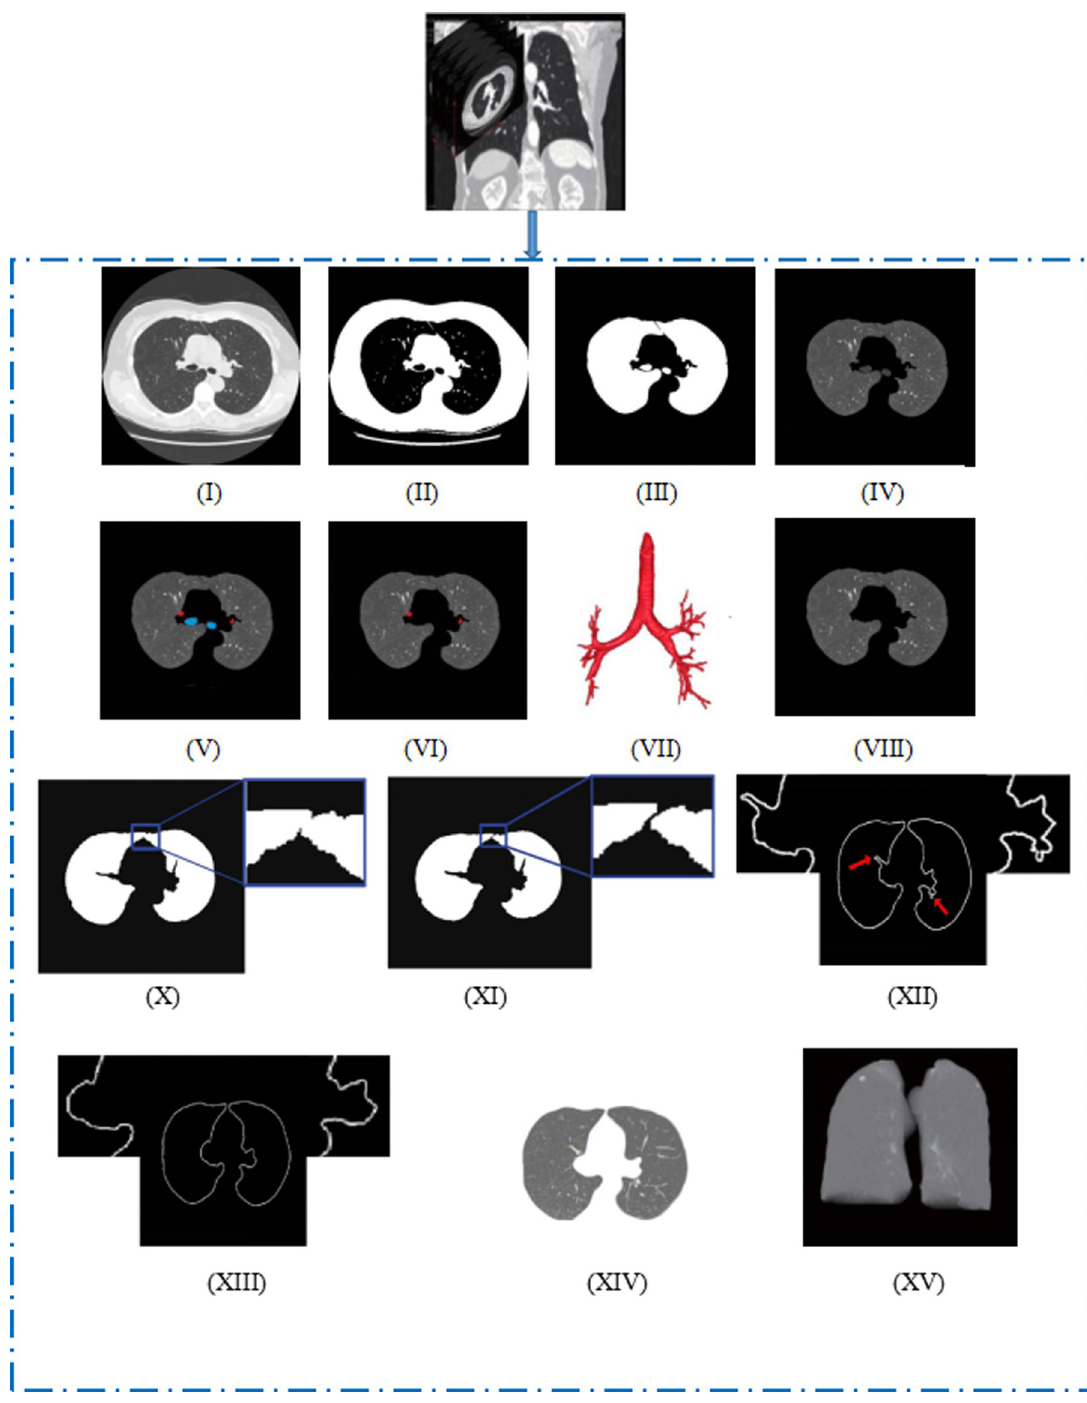
Fig 1. Lung segmentation process